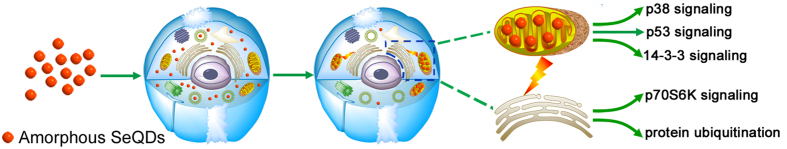
Proposed mechanisms of anti-proliferative effects of A-SeQDs on cancer cells.